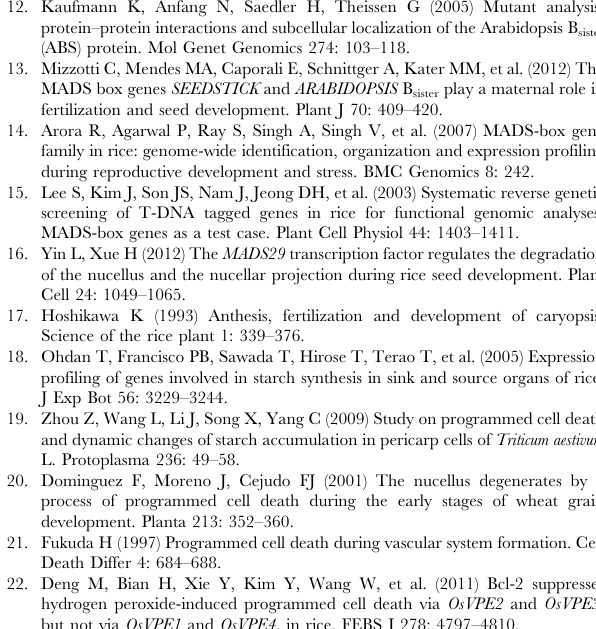
Figure S4 Transverse sections in the mid-region of control seeds at 0–7 DAP. ( A–C ) . Transverse sections of control seeds at stages 0, 1, 2 DAP. ( D–F ) . Magnification of OV and NU at stages 0, 1, 2 DAP, respectively. ( G–H ) . Transverse sections of control seeds at stages 3, 5, 7 DAP, respectively. ( J–I ) . Magnification of OV and NP at stages 3, 5, 7 DAP, respectively. NP, nucellar projection; NU, nucellus; OV, ovular vascular trace. Bar =50 m m in (A–C), 25 m m in (D–F), 100 m m in (G–H), 200 m m in I, and 50 m m in (J– L), respectively. (TIF) Figure S5 The promoter of OsVPE1 upstream about 3000 bp. A putative CArG-box at position -1827 in the upstream region of OsVPE1. (TIF) Figure S6 C-terminal sequence alignment of B sister Proteins. (TIF) Figure S7 RT-PCR analyses of OsMADS30 and OsMADS31 . ( A ). RT-PCR analyses of OsMADS30 and OsMADS31 at different development stages. DAP, days after pollination. ACTIN1 was used as control. ( B ). RT-PCR analyses of OsMADS30 and OsMADS31 expression in various floral organs of wild type plants at heading date stage. APT1 was used as a control. (TIF) Table S1 Gene specific primers used in this